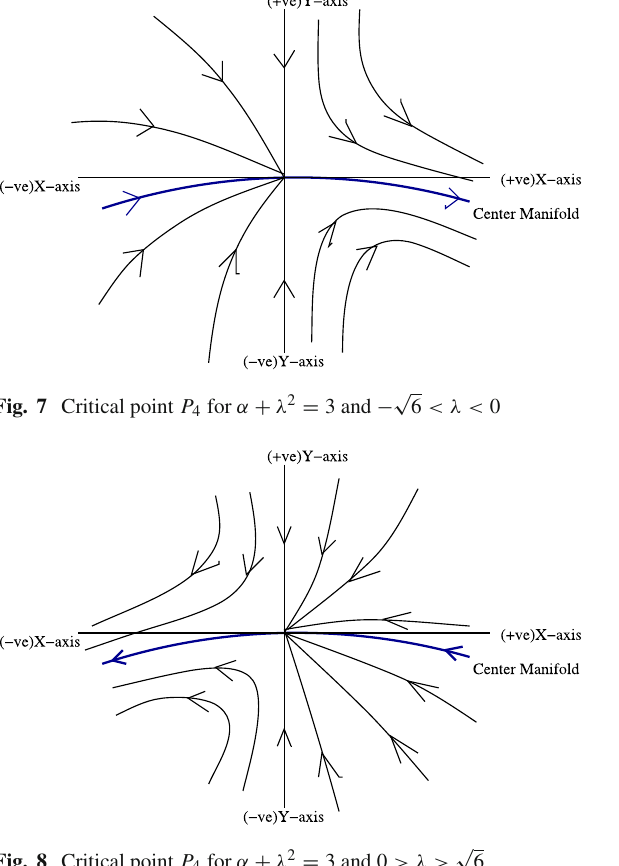
Fig. 8 Critical point P 4 for α + λ 2 = 3 and 0 > λ >